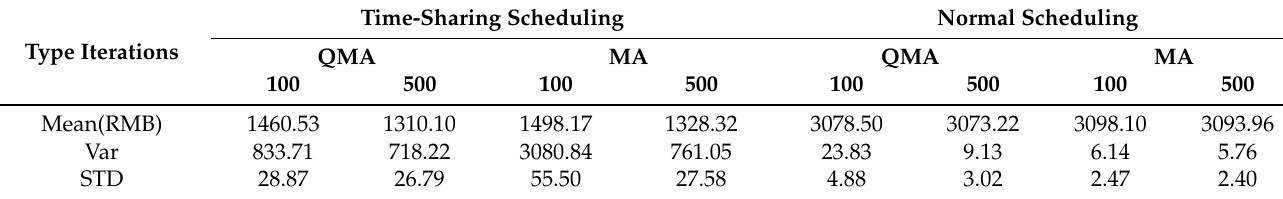
Figure 14. Microgrid operation cost after time-sharing scheduling. Table 8. The cost of